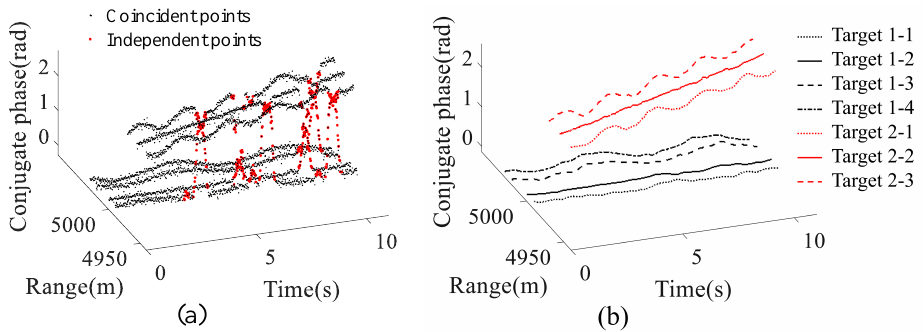
Figure 7. The simulated results of the proposed MDCM-LT algorithm. ( a ) The coincident points differentiated through the MDCM-based measurement partitioning method. ( b ) The tracking results derived through the LT algorithm.